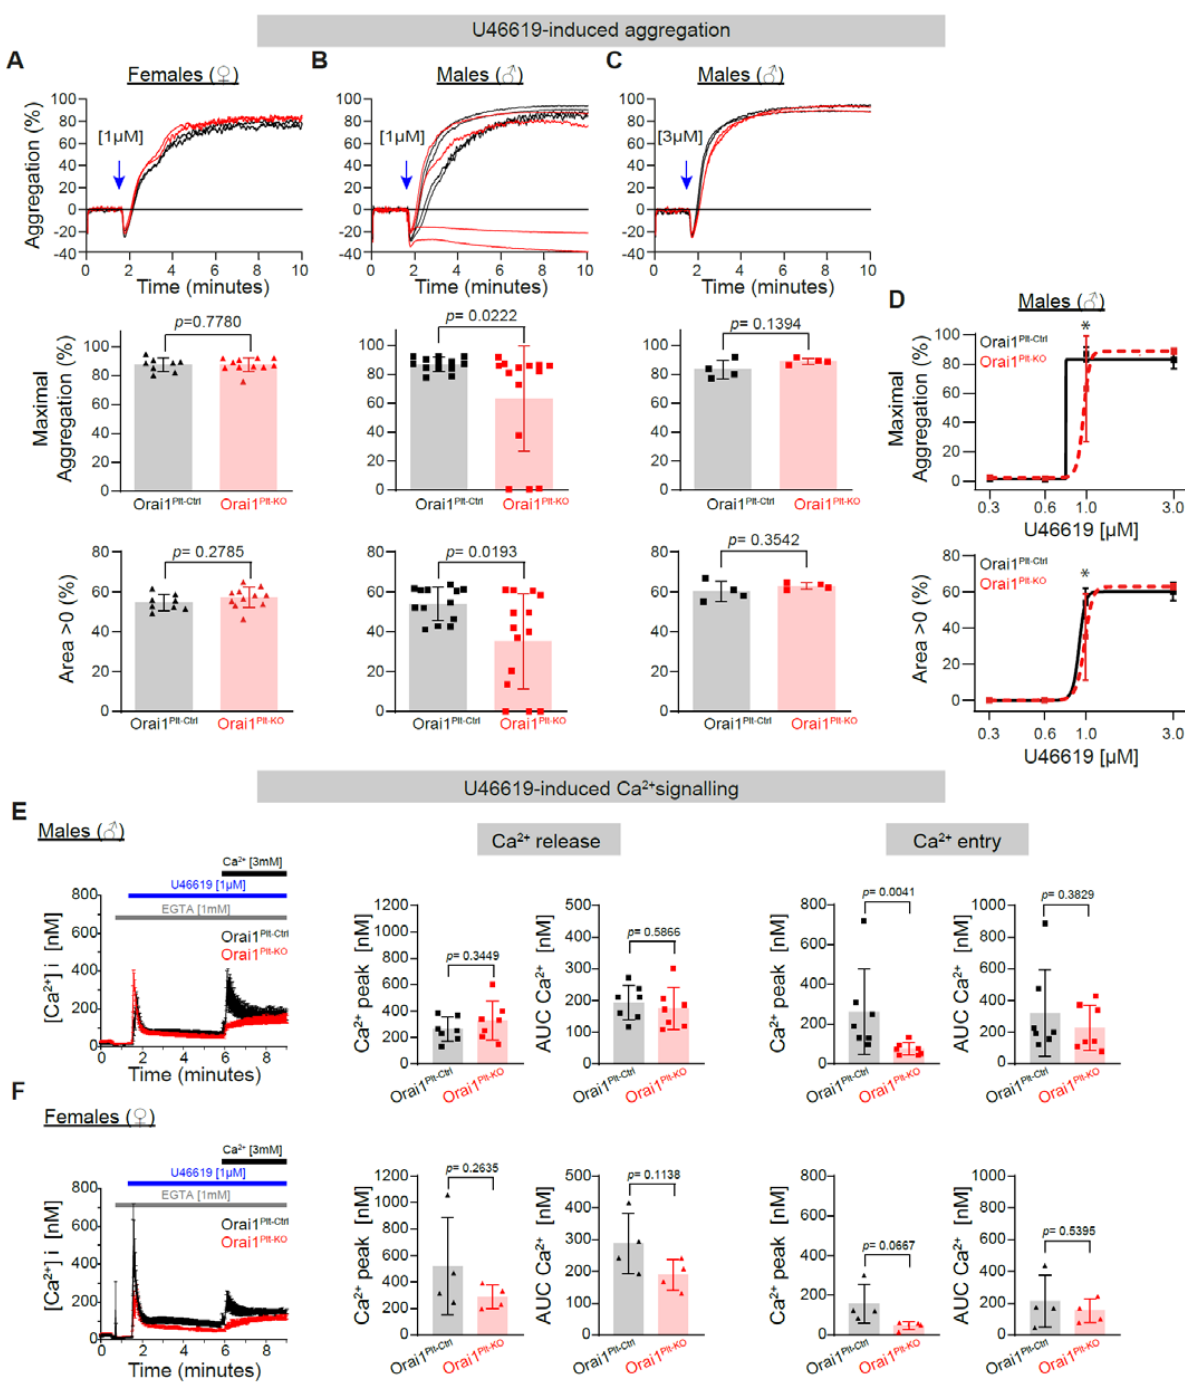
Figure 2. Impaired Thromboxane A2 analogue U46619-induced platelet aggregation and Ca 2+ signalling in Orai1-deficient platelets from male mice. U46619-induced platelet aggregation in washed platelets from Orai1 Plt-Ctrl (black) and Orai1 Plt-KO (red) mice was analysed ( A – D ). Representative original aggregation traces (upper panels), analysis of maximal aggregation (middle panels) and area under the aggregation curve (lower panels) after stimulation with 1 µM U46619 of platelets from female ( A ) or male ( B ) mice; similarly, analysis of platelets from male mice stimulated with 3 µM U46619 are depicted ( C ). Dose-response curves for the maximal aggregation (upper panel) and the area under the aggregation curve (lower panel) after U46619 stimulation of male platelets are shown